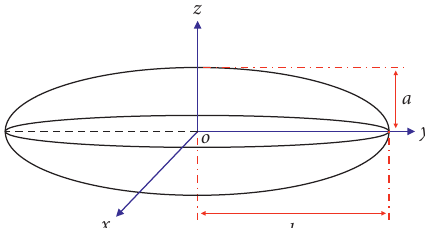
Figure 1: Schematic diagram of ellipsoidal horizontal salt rock cavern ( a and b are the radius of the minor axis and the major axis, resp.).